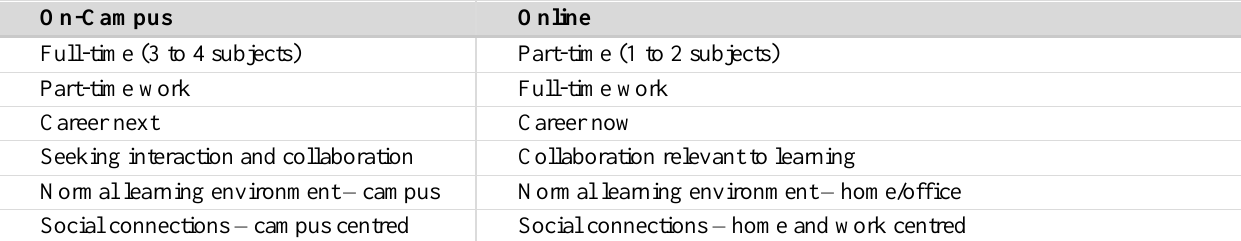
Differences between On-Campus and Online